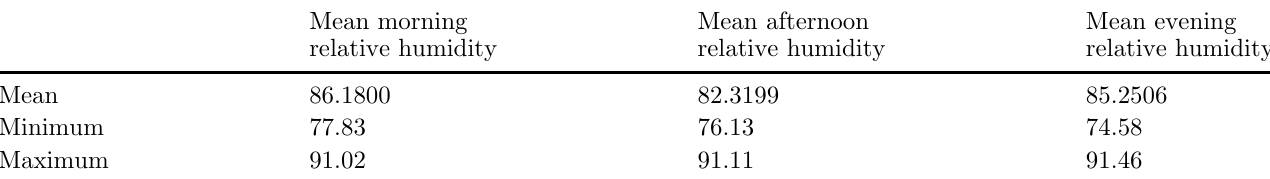
Table 11. Indoor relative humidity values during the wet